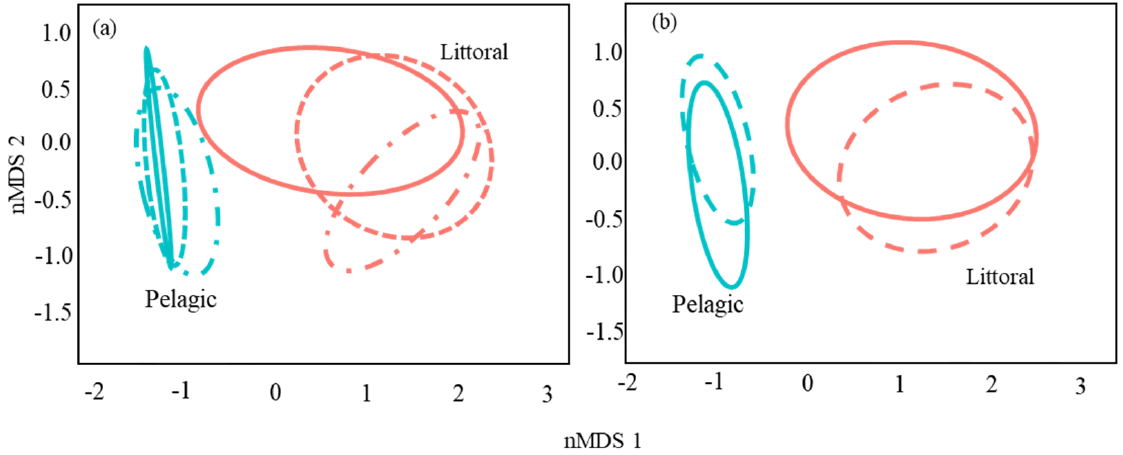
Figure 4. nMDS graphs built on arcisin square rooted numerical abundances and a Bray-Curtis dissimilarities matrix of the 12 prey species detected in the 182 analyzed catfish stomachs displaying ( a ) dietary niches as 40% standard ellipse area per sampling site (dashed line = site 1; dot-dashed line = site 2; solid line = site 3) and ( b ) dietary niches as 40% standard ellipse area per size class (solid line = Cass I < 100 cm and dashed line = Class > 100 cm). Stress was = 0.04, indicating two dimensions, and the ordination was sufficiently described. Table 4. PERMANOVA partition of the diet composition variation of the 182 analyzed catfish har- vested in Lake Maggiore (12 prey species) based on arcsin square rooted numerical abundances and Bray-Curtis dissimilarities with p-value calculated after 9999 permutations.